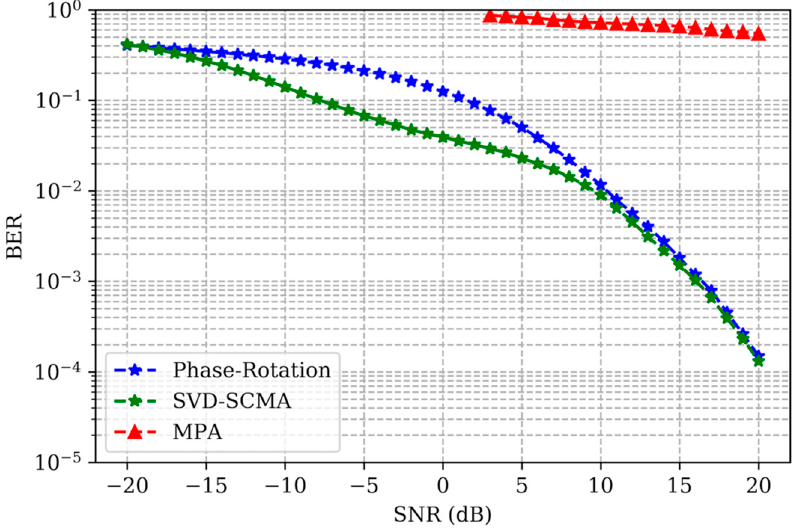
Figure 6. Bit error rate (BER) performance comparison.